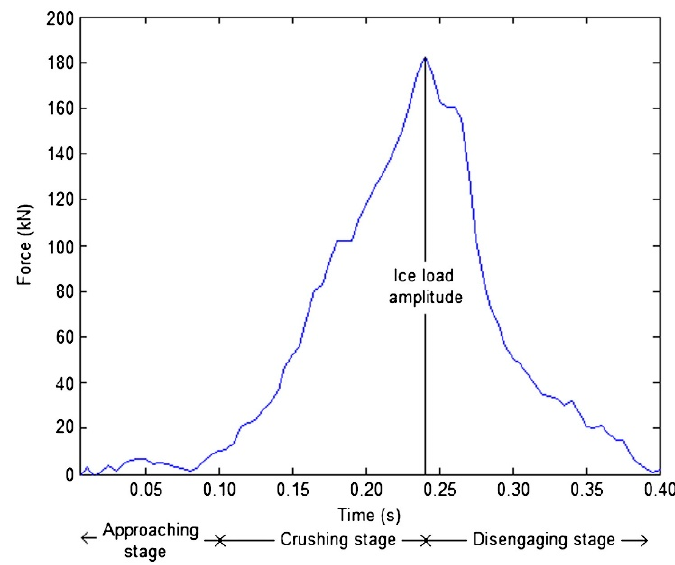
Figure 2. Ideal ice breaking process. Reproduced from [24], with permission from Elsevier, 2017.